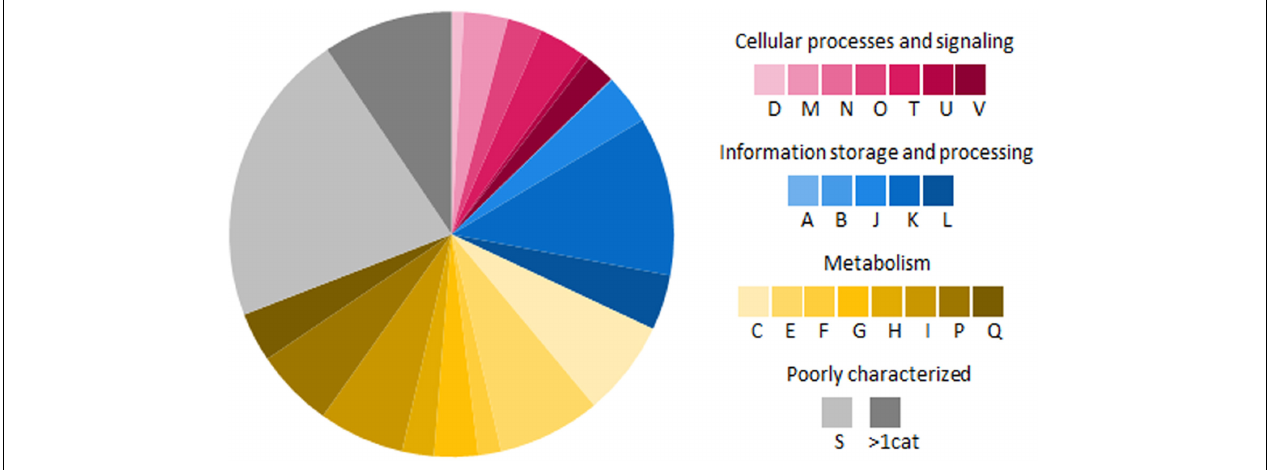
FIGURE 3 | Functional classification of genes encoding proteins in RL1 based on cluster of orthologous groups (COG) (Tatusov et al., 2000). All alphabets represent different COG functional classes: A , RNA processing and modification; B , Chromatin structure and dynamics; C , energy production and conversion; D , cell cycle control, cell division, and chromosome partitioning; E , amino acid transport and metabolism; F , nucleotide transport and metabolism; G , carbohydrate transport and metabolism; H , coenzyme transport and metabolism; I , lipid transport and metabolism; J , translation, ribosomal structure, and biogenesis; K , transcription; L , replication, recombination, and repair; M , cell wall, cell membrane, and cell envelope biogenesis; N , cell motility; O , posttranslational modification, protein turnover, and chaperones; P , inorganic ion transport and metabolism; Q , secondary metabolites biosynthesis, transport, and catabolism; S , no functional prediction; T , signal transduction mechanisms; U , intracellular trafficking, secretion, and vesicular transport; and V , defense mechanisms; > 1 cat , classified in more than 1